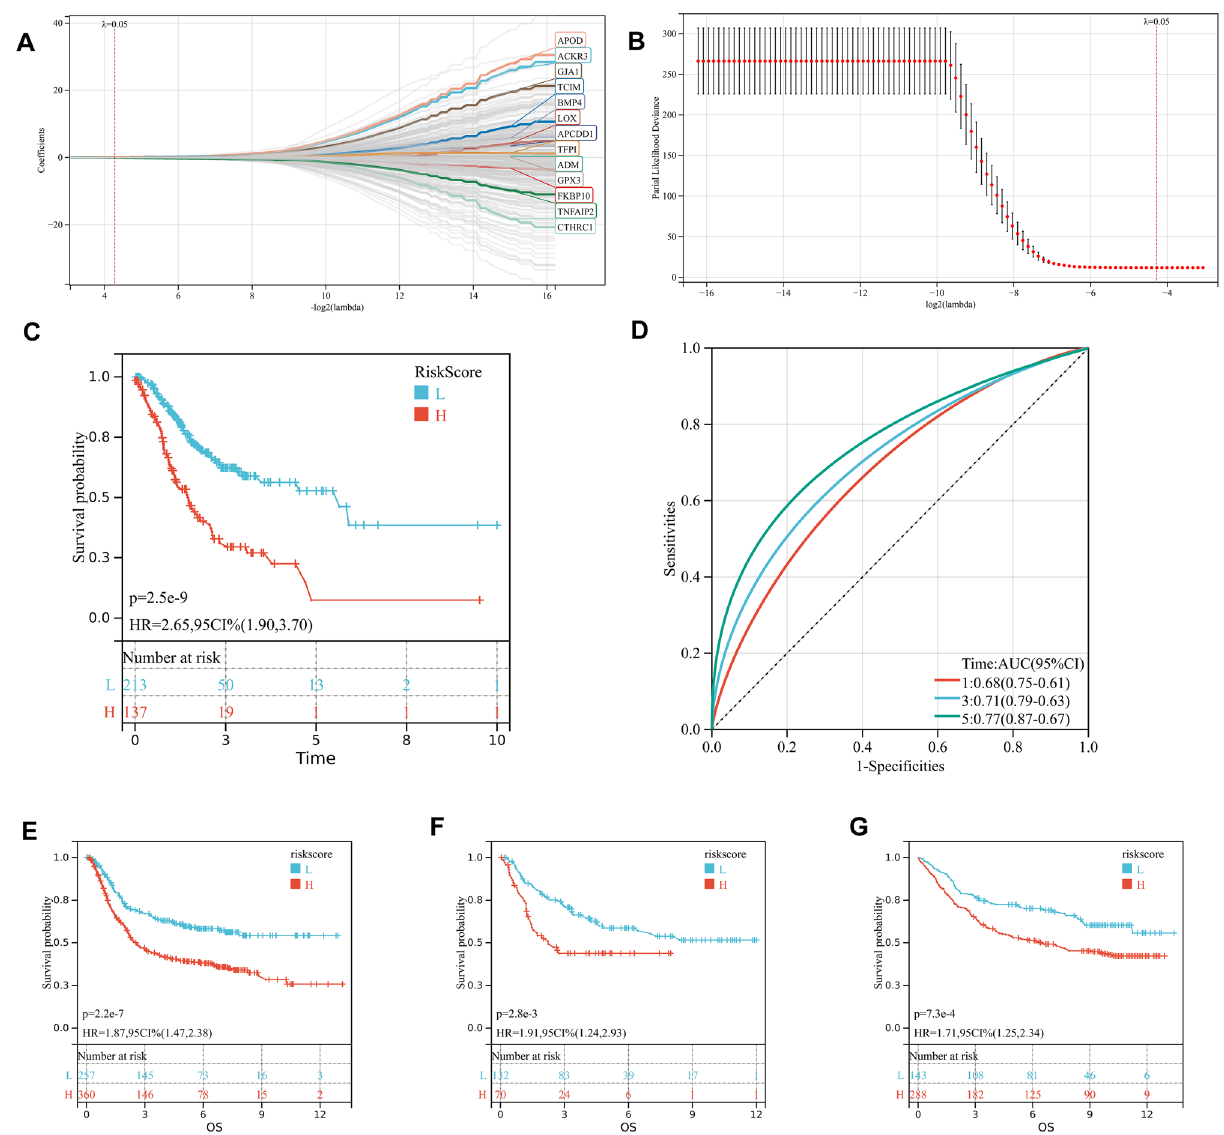
Figure 2. Construction of hypoxia-related prognostic model. ( A,B ) Partial likelihood deviance for the lasso regression and Lasso regression analysis. ( C,D ) Patients were divided into high-risk and low-risk subgroup based best cutoff, Kaplan–Meier analysis demonstrated that patients with higher hypoxia-related risk score exhibited worse overall survival in TCGA-STAD, ROC curves showing the predictive efficiency of the model on the 1-, 3-, and 5-years survival rate. ( E–G ) The prognostic difference was validated in 3 independent